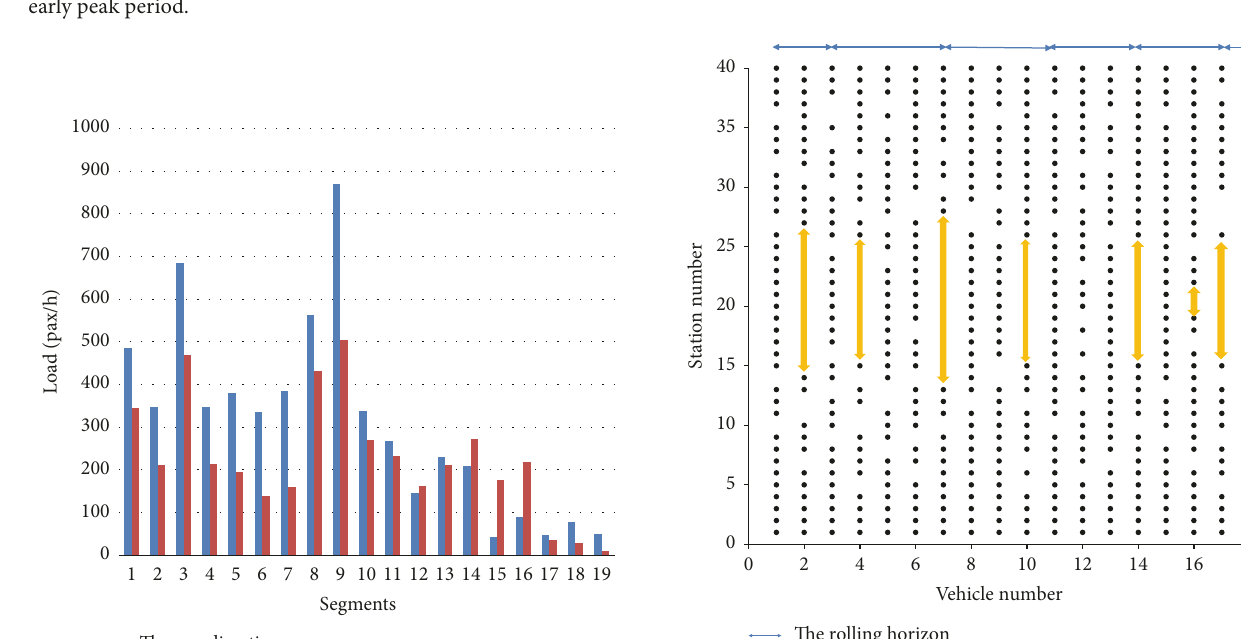
Figure 3: Average passenger demand in both directions during the early peak period.